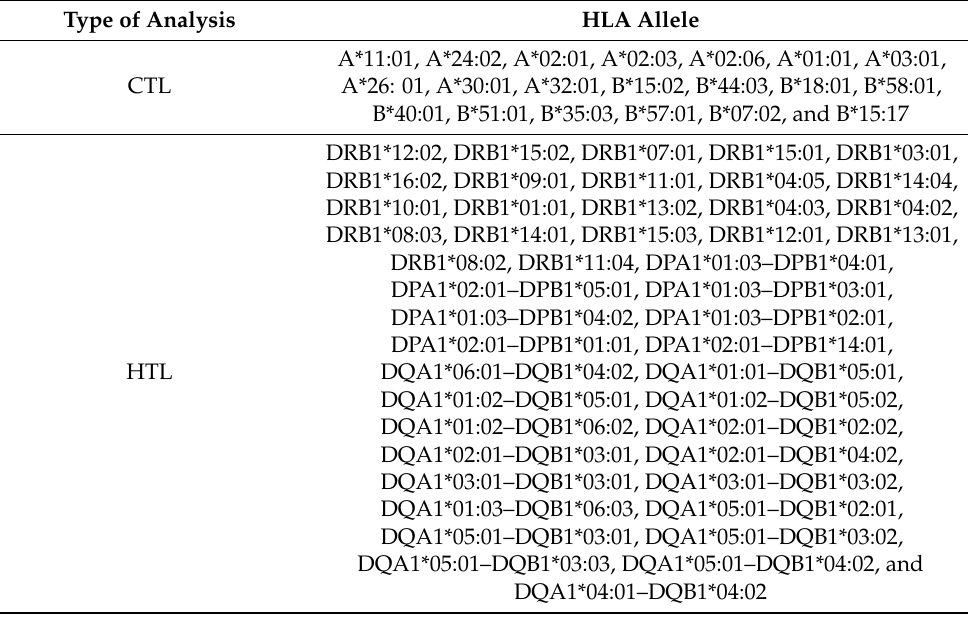
Table 1. HLA allele of the Indonesian Population used in the study. Type of